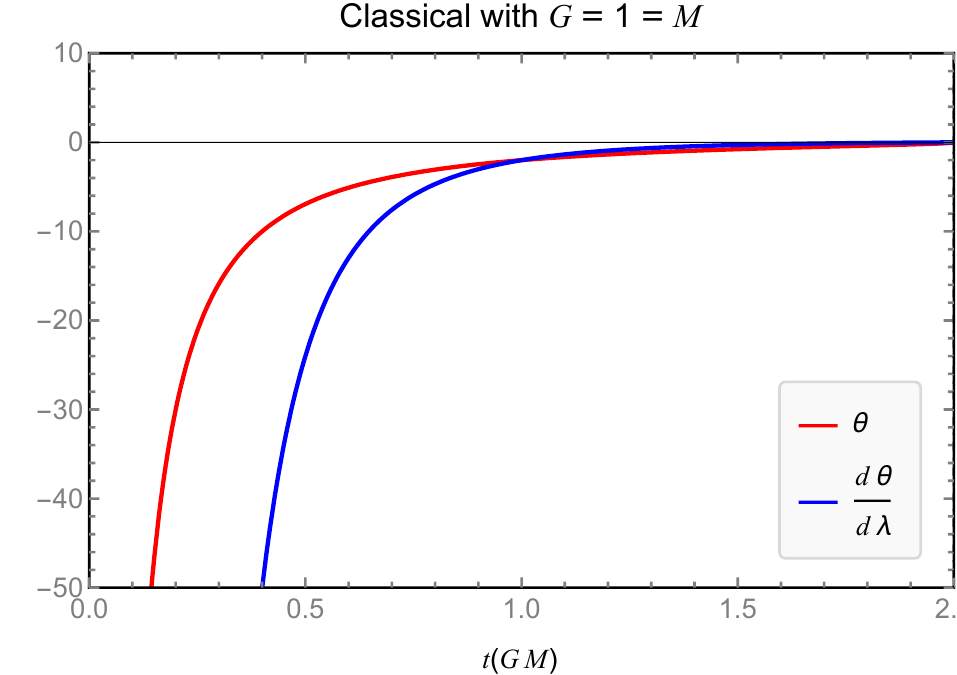
Figure 2. Classical null θ and d θ negative and has no